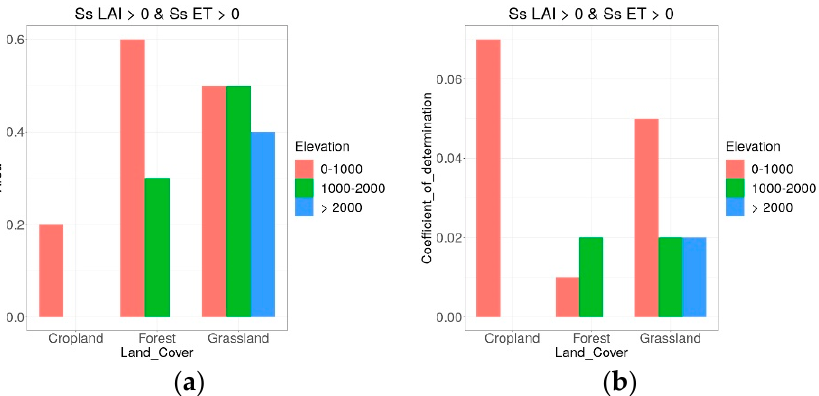
Figure 16. Percentage of area in each land cover class where LAI and SSEBop ET trends overlap, per elevation ( a ) and corresponding r 2 ( b ). The combination of positive or negative ET and LAI trends is indicated in the title of each plot. “Area” on the y axis is the percentage of the total area within each land cover class. Ss is the Sen’s slope of the trend at 5% significance from 2003 to 2019.